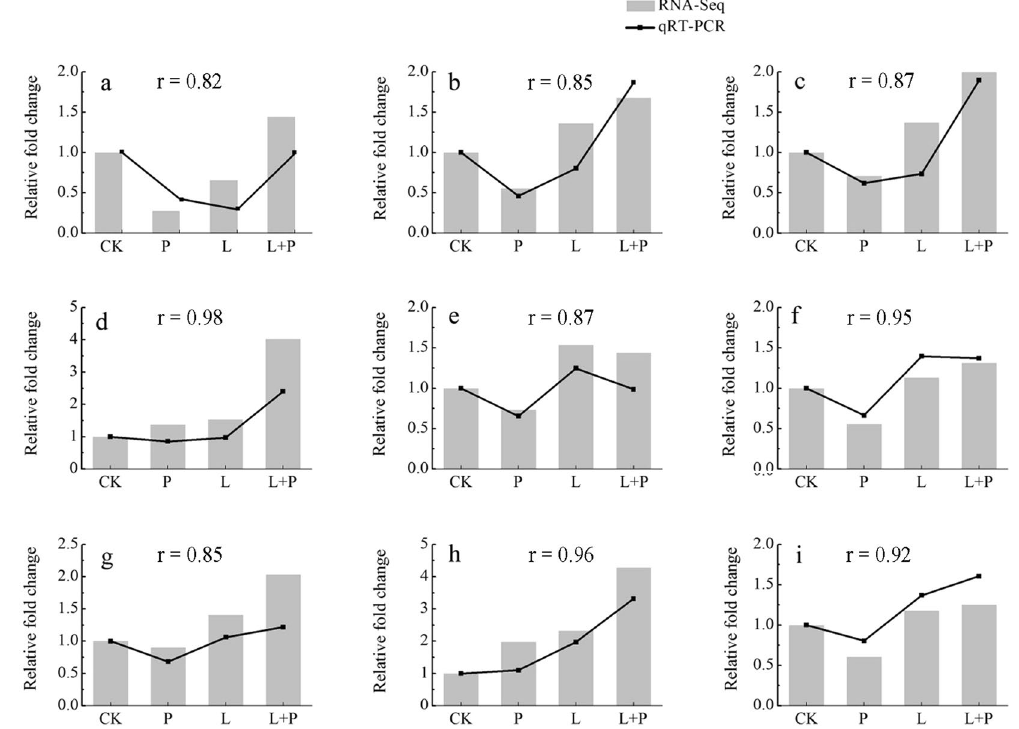
Figure 6. Expression of nine differentially expressed genes in He-Ne laser pretreatment on wheat seedlings under drought stress. Correlation between the expression profiles of the nine transcripts determined by RNA- Seq and qRT-PCR. See notes to Table 1. Genes are ( a ) plant peroxidase; ( b ) class III peroxidase; ( c ) glutathione S-transferase; ( d ) catalase immune-responsive domain; ( e ) heat shock protein 70 family; ( f ) WRKY transcription factor; ( g ) glycoside hydrolase; ( h ) photosystem II PsbR protein; ( i ) drug/metabolite transporter. The y-axes show expression levels (fold difference) determined by qRT-PCR and